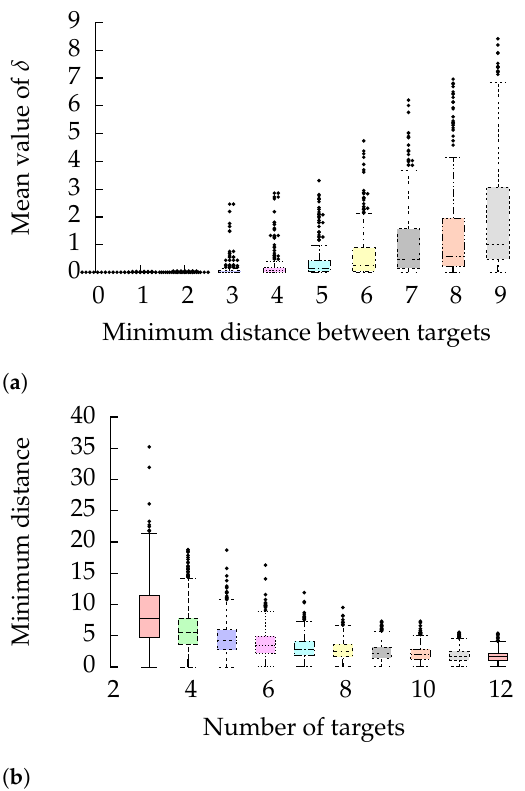
Figure 3. Statistical evaluation of the distances of the target vertices on the San Francisco dataset. ( a ) Correlation between δ and the minimum distance between all targets. ( b ) Anti-correlation between and the minimum distance between all targets, caused by the uniform |T |